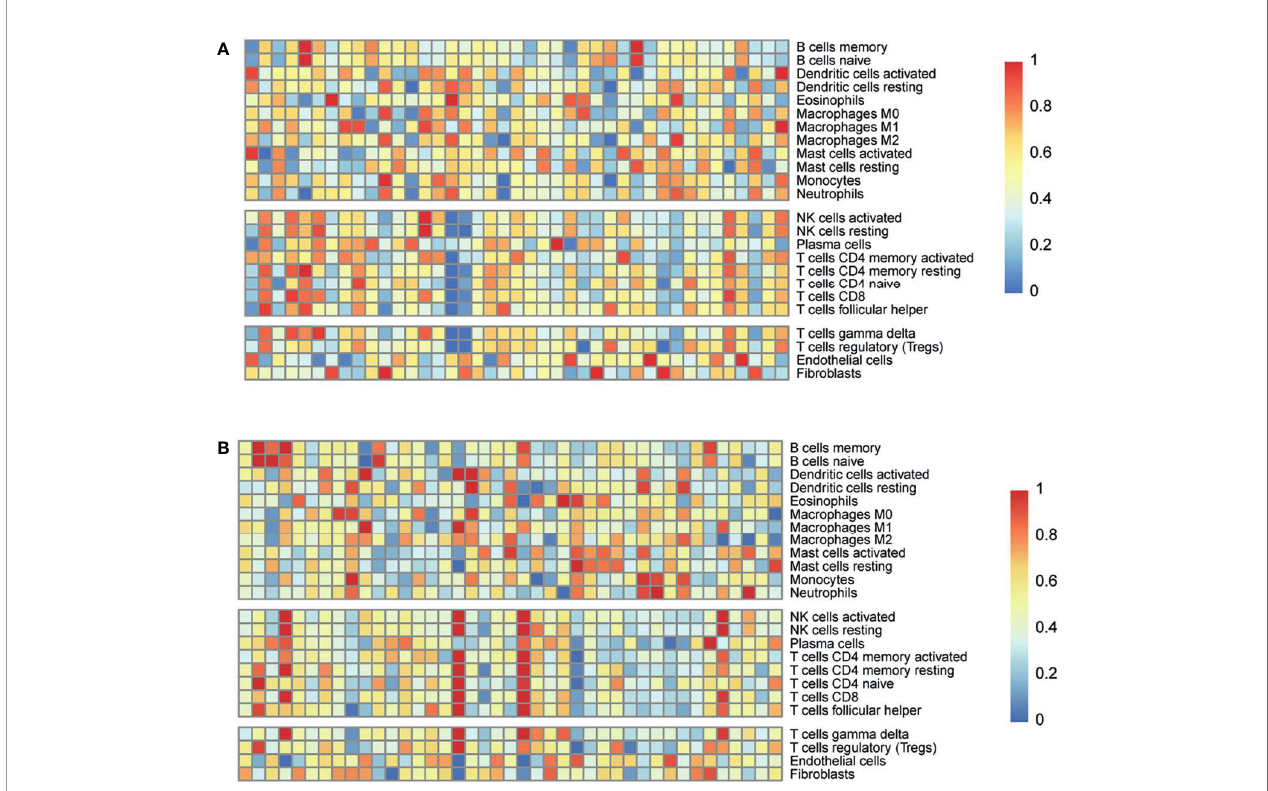
FIGURE 6 | Estimation of the abundance of immune cell in fi ltration in the Genomic Data Commons dataset from the Cancer Genome Atlas. The abundance of in fi ltration of 24 types of immune cells in the low-risk (A) and high-risk (B)